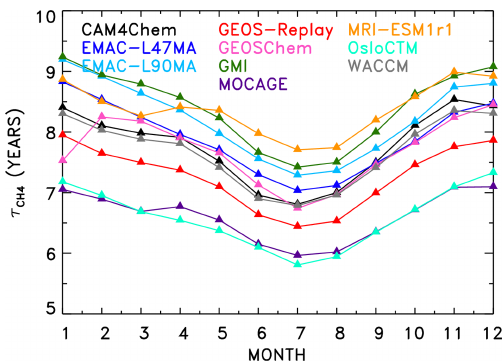
Figure 2. Seasonal variation in CH 4 lifetime for the year 2000 for the CCMI specified dynamics (REF-C1SD) and chemical transport model